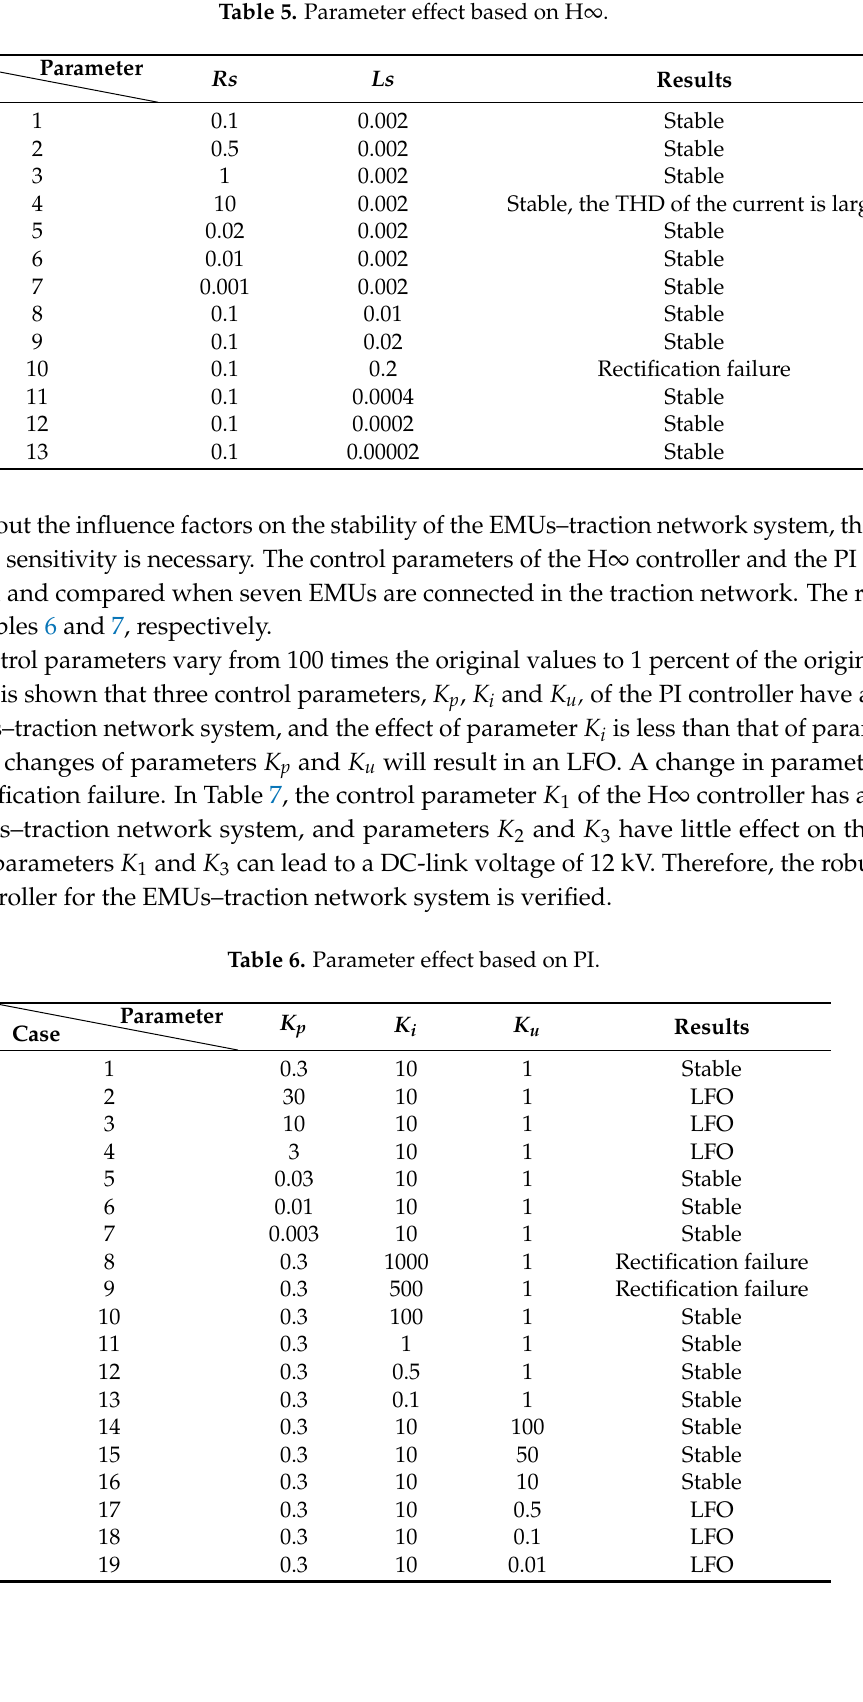
Table 5. Parameter effect based on H ∞ .